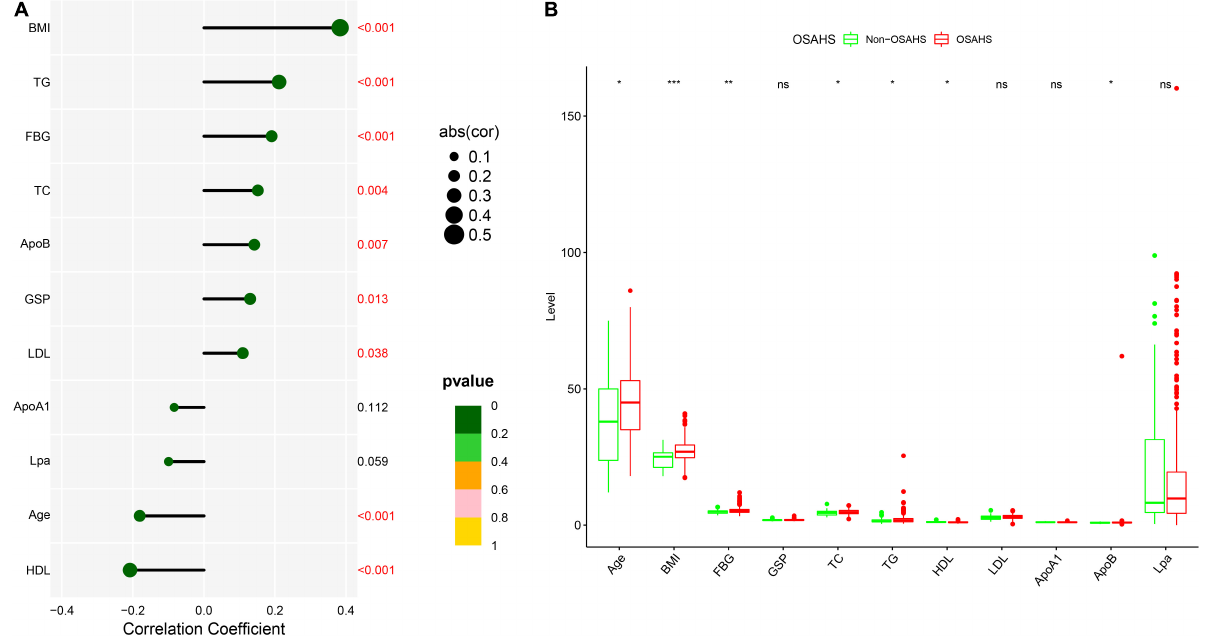
observed in the OSAHS group ( Table 1 and Figure 2B ). Through